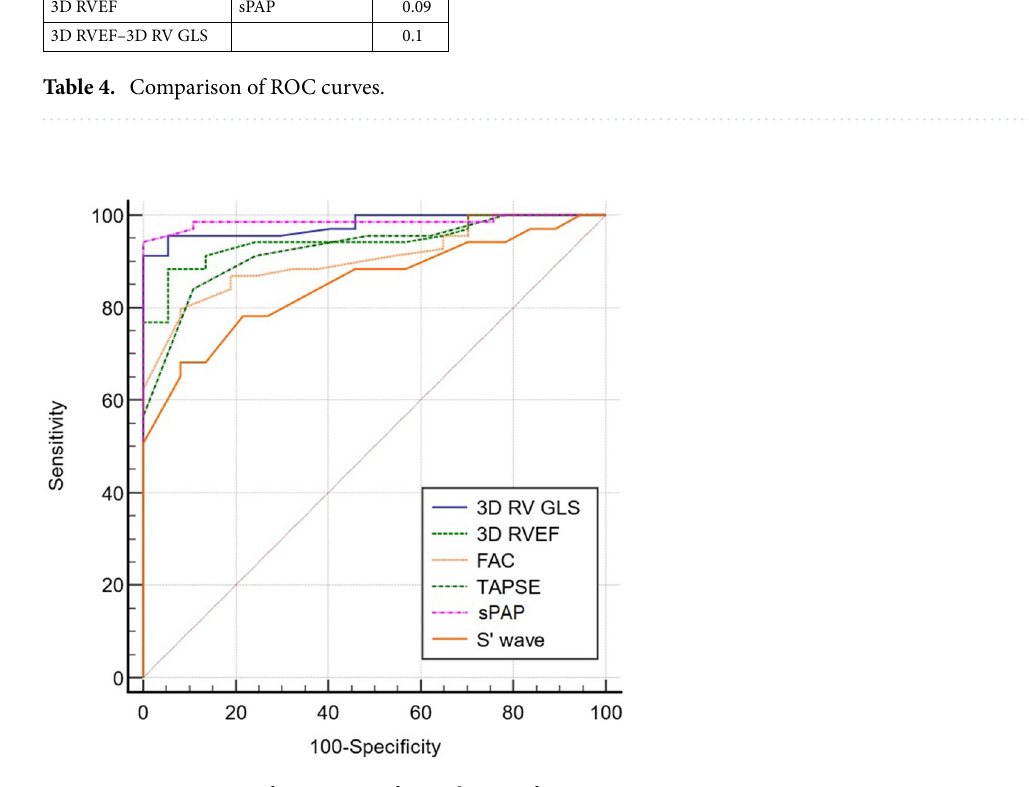
Figure 3. Comparison of ROC curves for prediction of